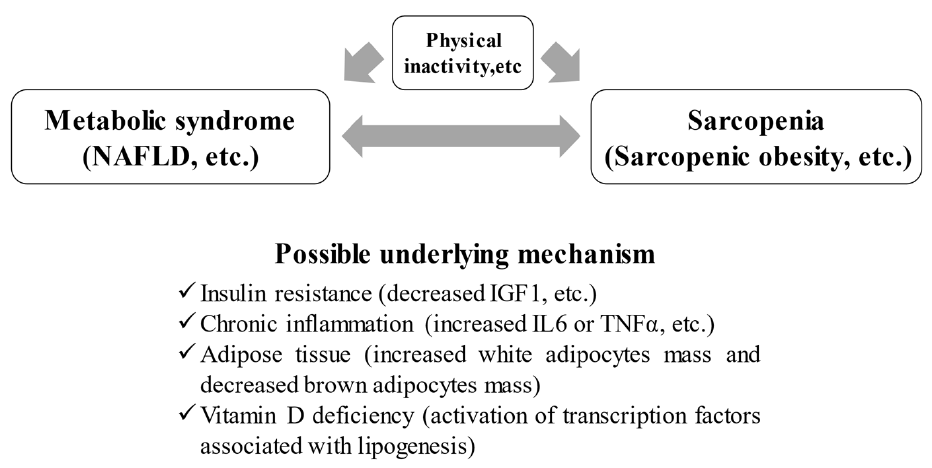
Figure 1. Correlation between metabolic syndrome and sarcopenia. NAFLD; nonalcoholic fatty liver disease, IGF; insulin-like growth factor.